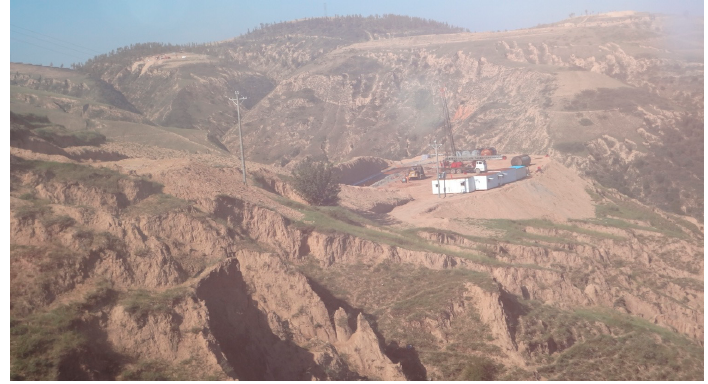
Figure 24. Photo of Oilfield test in Jinbian.